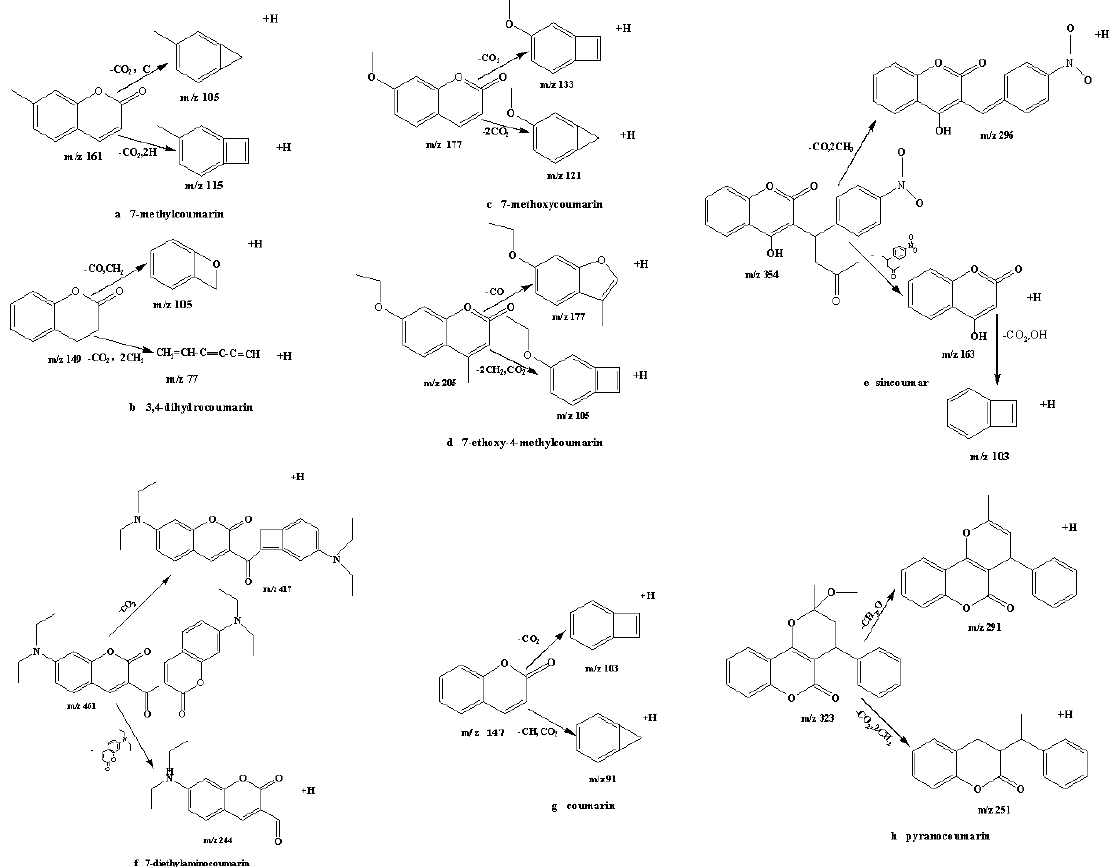
Figure 3. Fragmentation pathways of coumarin and its derivatives.